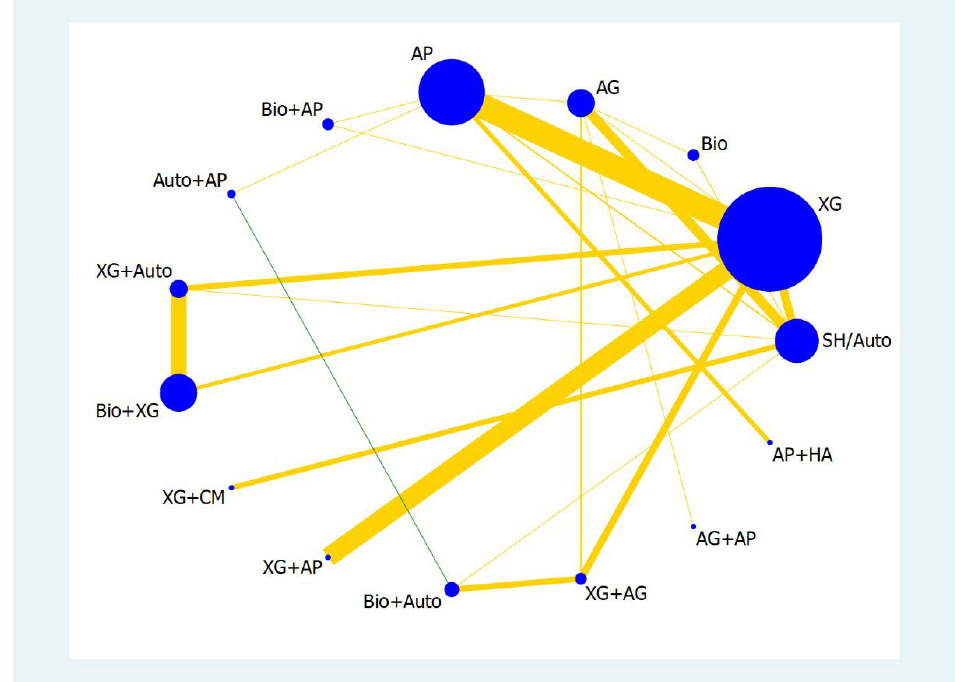
Figure 2. Network plot for <4 mm RBH. The size of blue circles (nodes) is proportional to the number of patients for the specific group of graft material. The thickness of lines between nodes is proportional to the number of comparisons between two or more groups of graft material. The colour of the lines indicates the risk of bias: yellow represents moderate and green indicates low risk of bias.